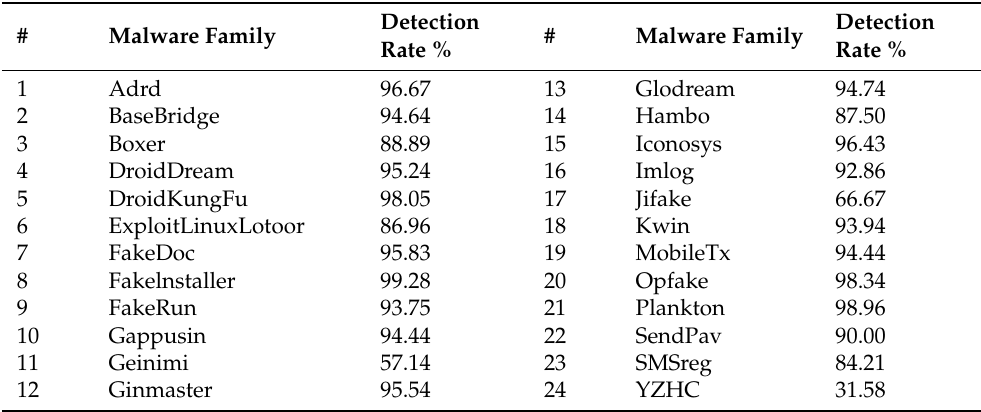
Table 4. Detection rate of each malware family using DIP.